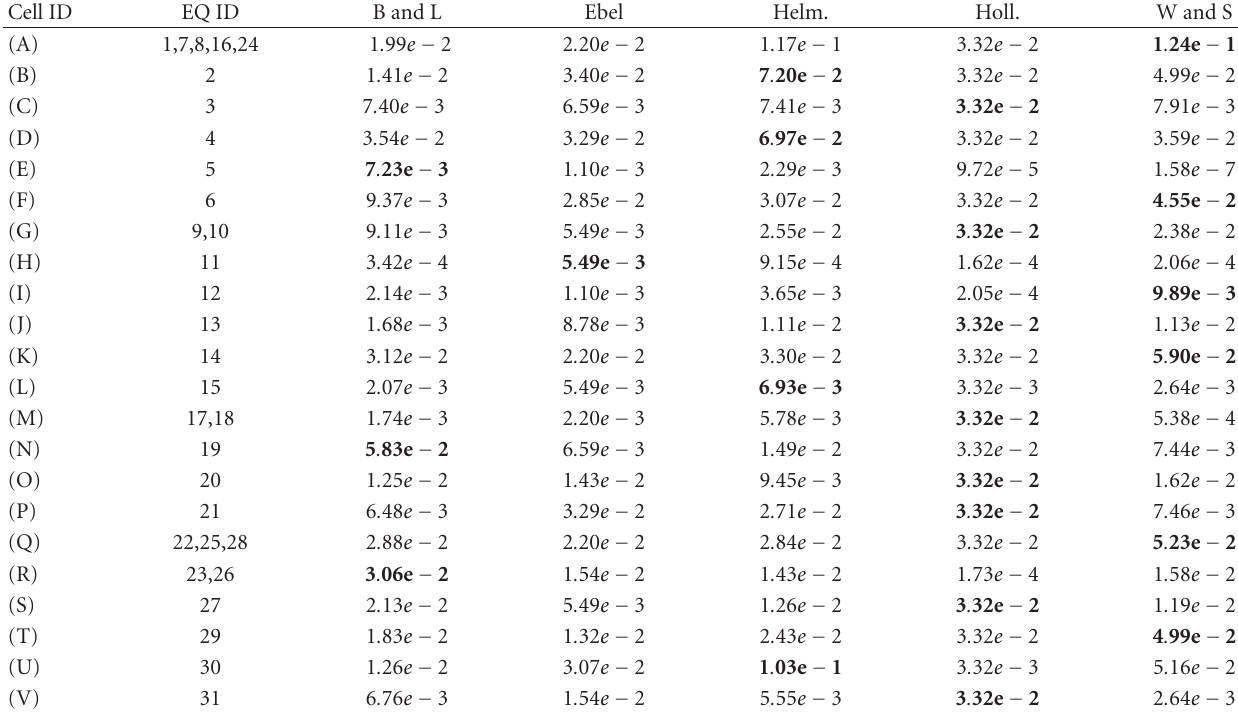
Table 2: Cell scores λ fi of an earthquake with M ≥ 4 . 95 for the 22 cells in which earthquakes occurred during the test period. The association of cell IDs (A–V) with the earthquake IDs (1–31) from Table 1 is given. Five submitted forecasts are given: (1) Bird and Liu (B and L), (2) Ebel et al. (Ebel), (3) Helmstetter et al. (Helm.), (4) Holliday et al. (Holl.), and (5) Wiemer and Schorlemmer (W and S). The highest (best) scores are in bold.